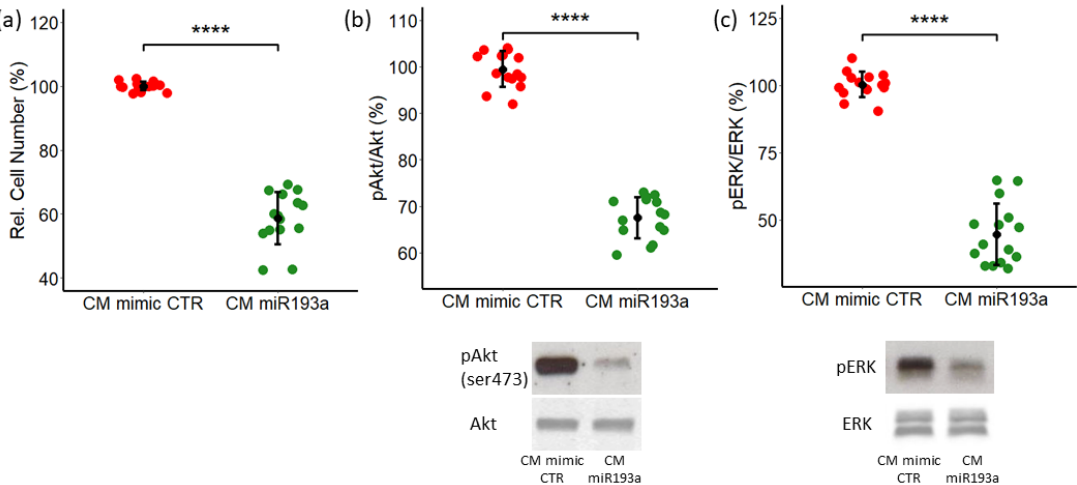
Figure 4. Secretome from miR193a-3p transfected MCF-7 cells inhibits LEC proliferation and AKT, as well as ERK phosphorylation. LECs were cultured in CM miRNA for 48 h and cell proliferation was assessed by cell counting ( a ). Western blotting was performed on the whole cell lysate of LECs exposed to CM miRNA for 45 min. Representative Western blots for AKT ( b ) and ERK ½ ( c ) phosphorylation are depicted in the graph. Total ERK and total AKT were used for normalization. Experiments were performed at least three times in triplicates and data represent mean ±SD. p < 0.00001 ****, compared to the respective control.